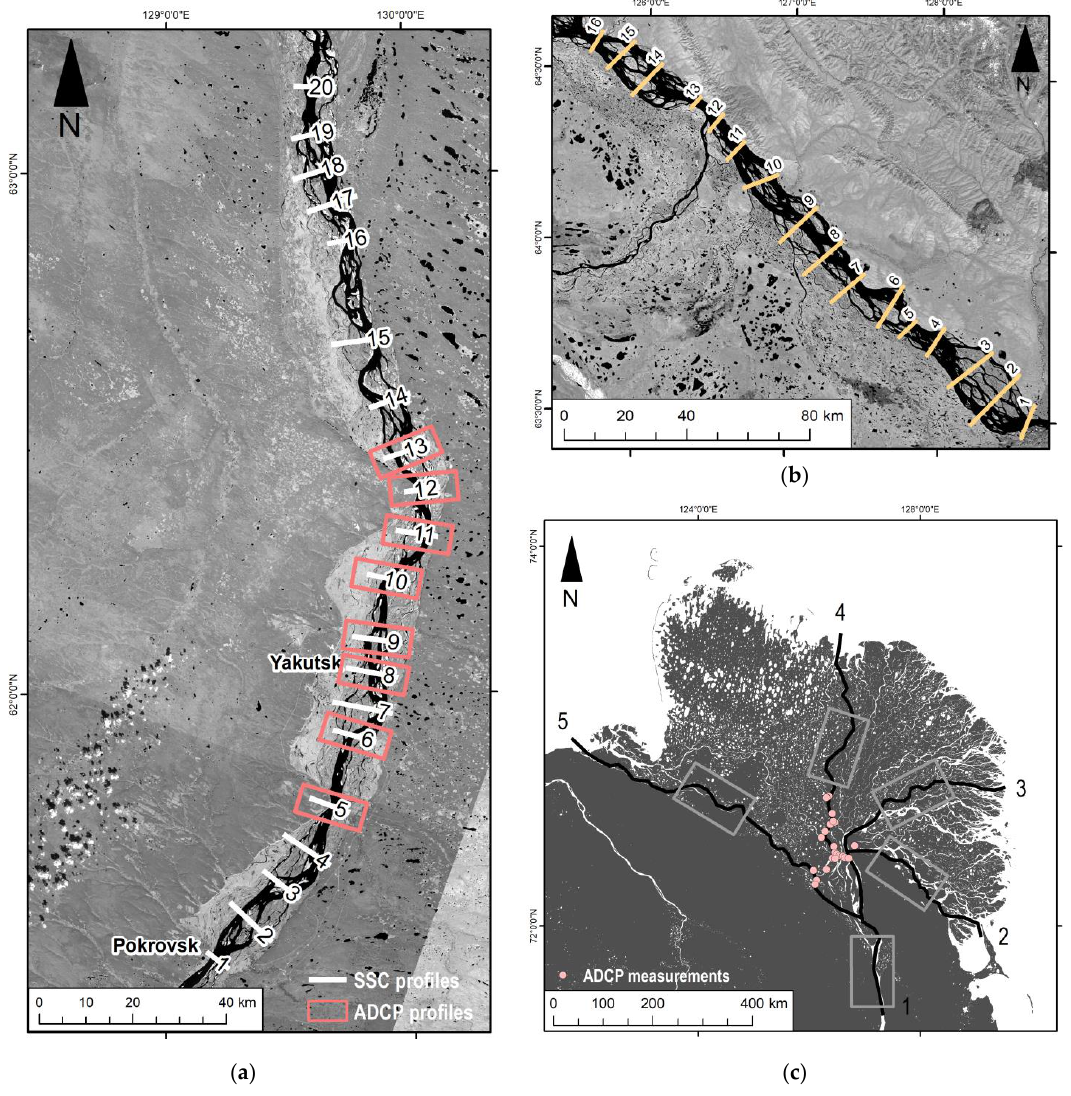
Figure 2. Schematic map of the sections and profiles, where SSC changes were calculated: ( a ) numbers represent the profile locations of the SSC sections in case study 1; ( b ) numbers represent the profile locations of the SSC sections in case study 2; ( c ) numbers represent channels in the Lena River delta (case study 3): 1 — main channel; 2 — Bykovskaya, 3 — Trofimovskaya, 4 — Tumatskaya, 5 — Olenekskaya branches; grey boxes are polygons for calculating average sediment concentrations.